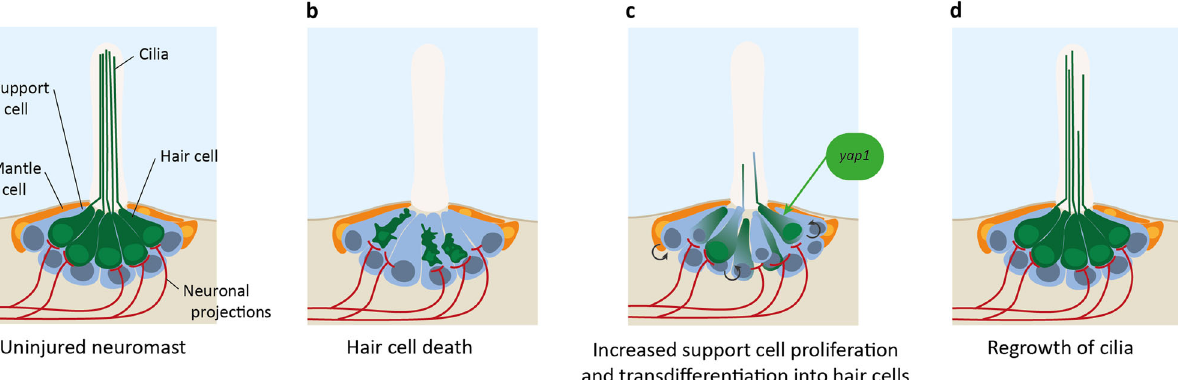
Fig. 6 Overview of neuromast regeneration. a Uninjured neuromasts consist of hair cells (green) with cilia projecting into the external liquid, support cells (blue), mantle cells (orange), and afferent sensory neurons (red) that project to the brain. b Administration of aminoglycosides or Cu 2 + causes speci fi c hair cell death. c Support cell proliferation increases and cells transdifferentiate into hair cells. yap1 promotes support cell transdifferentiation. d Hair cell cilia regrowth restores neuromast